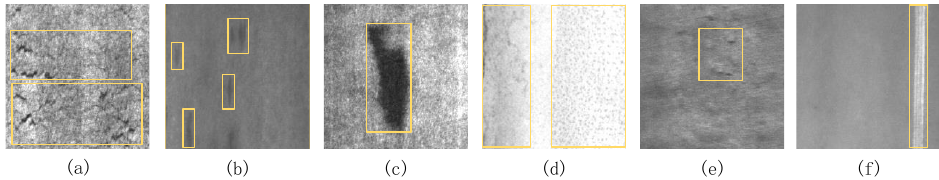
Figure 6. Defect images in NEU-DET. The yellow box is a groundtruth of a defect. ( a ) Crazing. ( b ) Inclusion. ( c ) Patches. ( d ) Pitted surface. ( e ) Rolled-in scale. ( f )